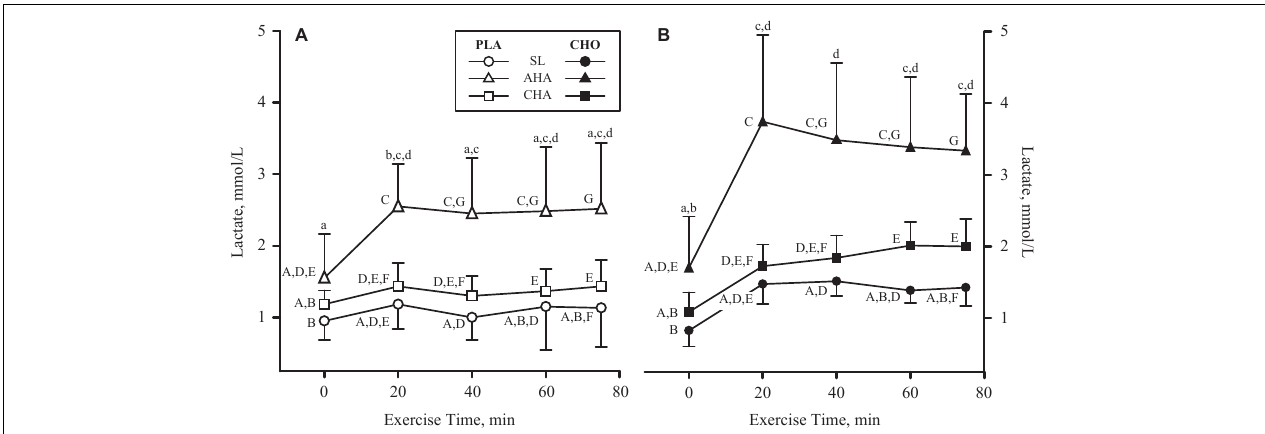
FIGURE 6 | Mean + SD of plasma lactate concentrations in participants provided non-nutritive placebo (PLA, n = 6, open symbols, (A) or 1.8 g/min carbohydrate (CHO, n = 8, 65.25 g fructose + 79.75 g glucose, closed symbols, (B) during 80-min steady-state exercise (treadmill walking) at sea level (SL) and at 4,300 m altitude, within 5–7 h after arrival (acute high-altitude, AHA) and again on the 22nd day of continuous residence at high-altitude (chronic high-altitude, CHA). Time points not sharing the same lower case letter are different (treatment by time interaction, P < 0.05) and time points not sharing the same upper case letter are different (time by phase interaction, P <